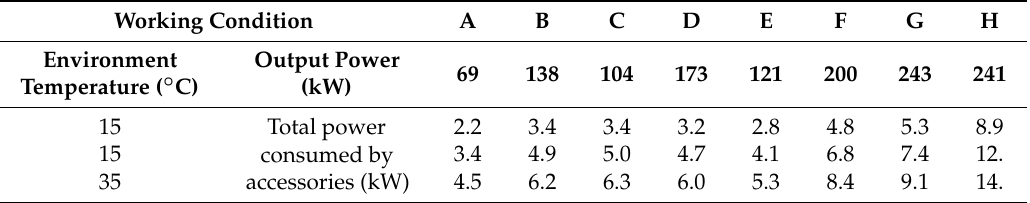
Table 6. Power consumption of the original machine at various environmental temperatures.